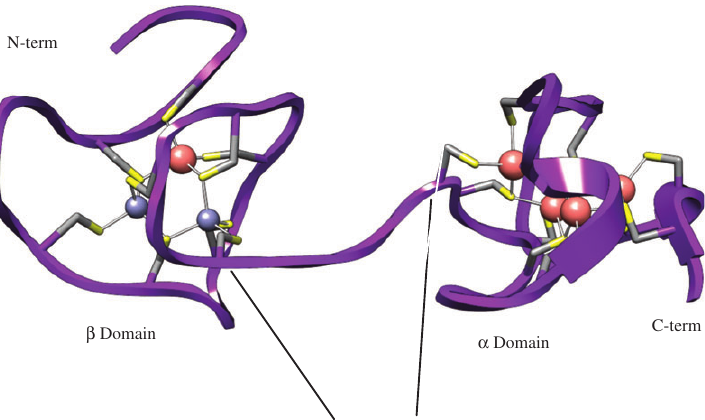
Figure 2 3D structure and amino acid sequence of the rat Zn Cd -MT2 complex, drawn with the coordinates available at the 4MT2 entry of 2 5 PDB. Zn(II) and Cd(II) ions are represented as small and big spheres, respectively; the Cys residues as sticks; and the S-Cd bonds as solid lines. The underlined region corresponds to the megalin-interacting fragment. The structure was represented using the UCSF Chimera soft- ware. Chimera is developed by the Resource for Biocomputing, Visualization and Informatics at the University of California, San Francisco, USA